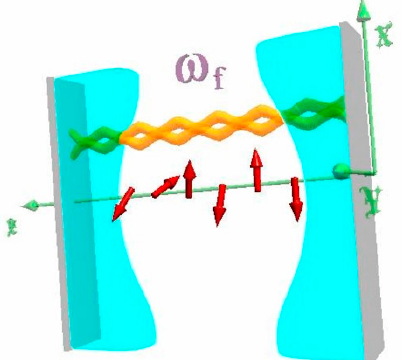
Figure 1. Particle with spin ½ in XY spin chain interacting with a quantized electromagnetic field in a cavity.